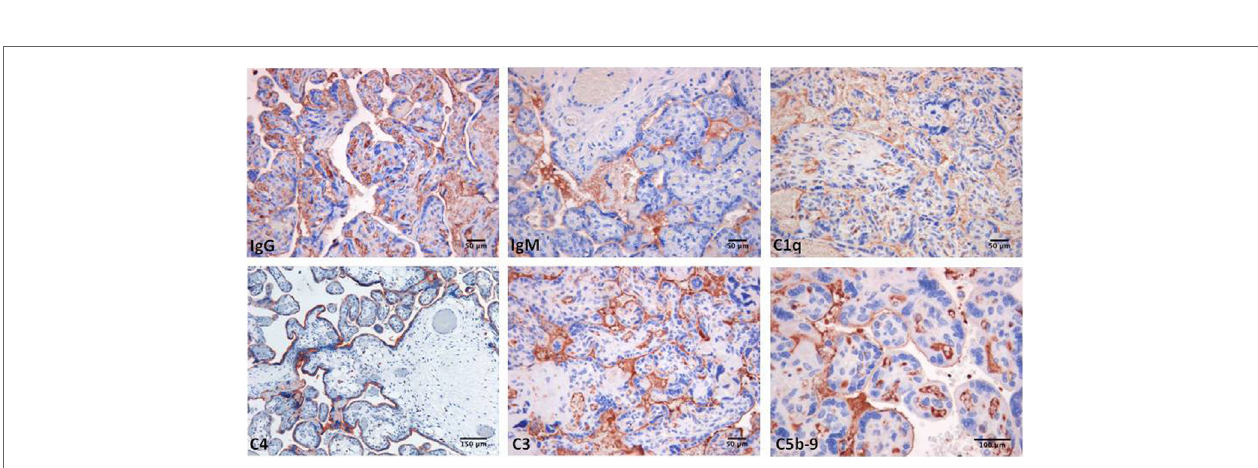
FiGUre 1 | Immunoperoxidase staining of a representative placental decidua from a primary antiphospholipid syndrome patient showing deposition of immunoglobulin (Ig) and various C components (20 ×